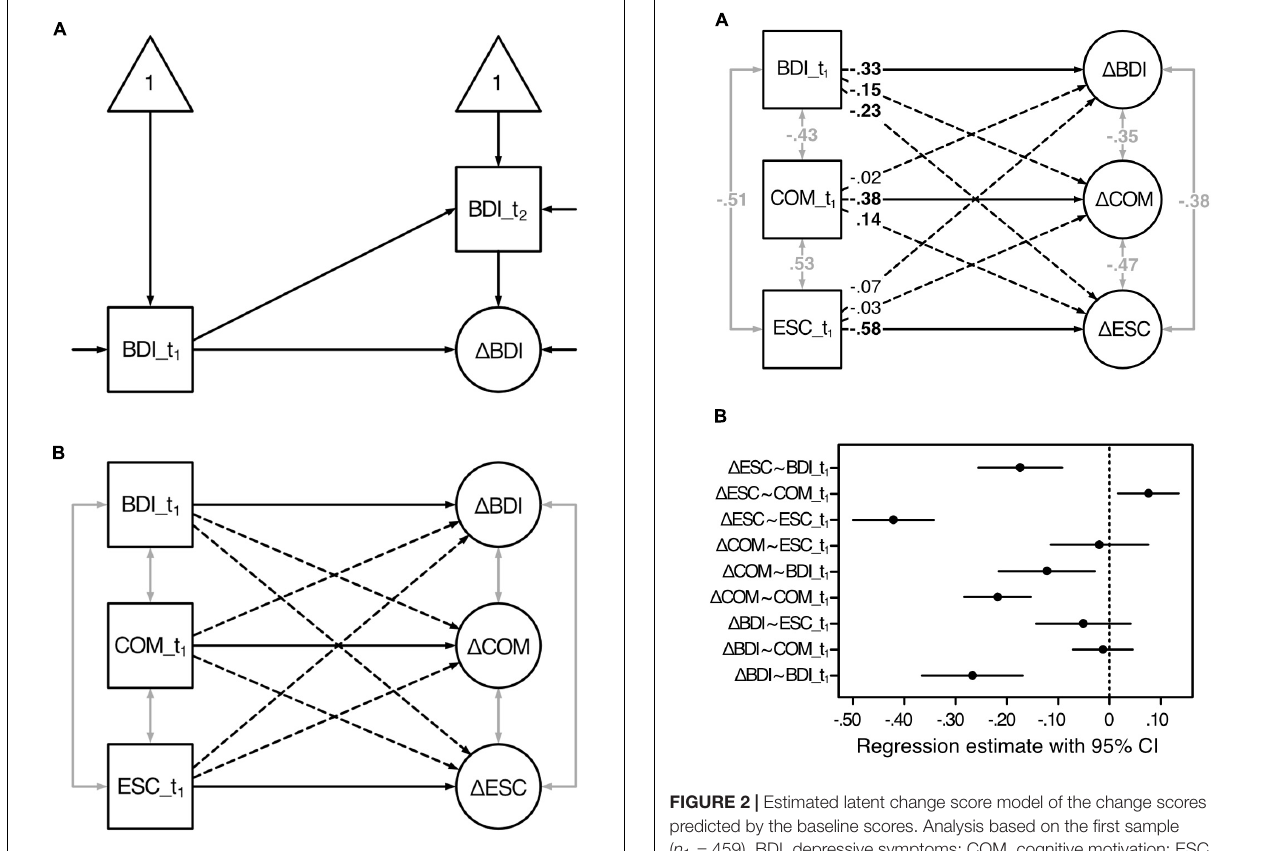
FIGURE 1 | Latent change score model of the hypothesized longitudinal effects between all variables’ baseline and change scores. BDI, depressive symptoms; COM, cognitive motivation; ESC, effortful self-control. t 1 denotes to the first assessment (baseline); t 2 denotes to the second assessment; (cid:49) denotes to the latent change score. Squares indicate observed variables; ellipses indicate latent variables; triangles indicate constants (intercepts). One-sided arrows indicate directed effects (regression coefficients) except for those without origin (variances), two-sided gray arrows indicate undirected relationships (covariances). (A) Univariate latent change score model exemplified by depressive symptoms. Depressive symptoms are assessed at two time points (BDI_t 1 and BDI_t 2 ). The change ( (cid:49) BDI) between the two assessments is modeled as latent variable. (B) Simplified model (without t 2 observed variables, intercepts, and variances) illustrating the longitudinal effects: The change score of each variable is predicted by its corresponding baseline scores (i.e., self-feedback indicated by solid lines) as well as the baseline scores of the two remaining variables (i.e., cross-domain coupling indicated by dashed lines).